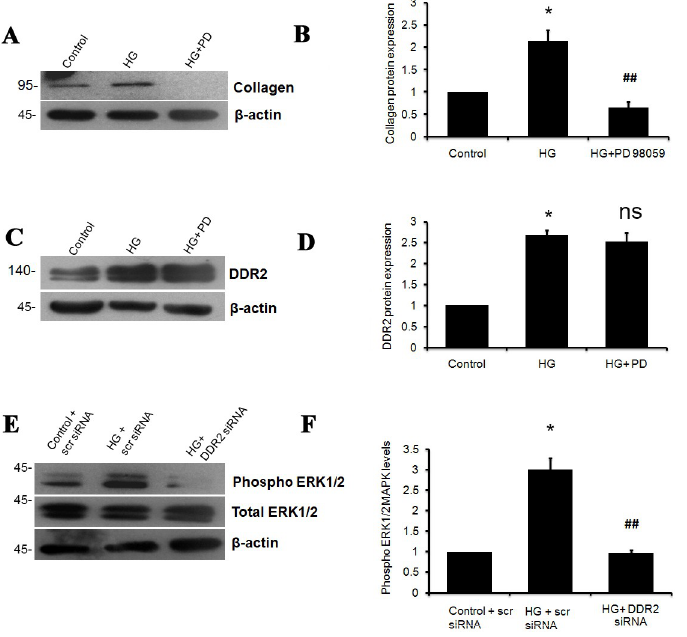
Fig 4. ERK1/2 MAPK mediates DDR2-dependent collagen gene expression in HG-treated cells. (A-D) Sub- confluent quiescent cultures of vascular adventitial fibroblasts in M199 were pre-treated with ERK1/2 inhibitor, PD98050, for 1 h and subsequently with HG for 12 h. Protein was isolated at 12 h post-HG treatment and subjected to western blot analysis for detection of: ( A and B) Collagen type I alpha 1 protein expression; � p < 0.05 vs. control, ##p < 0.01 vs. HG (One-way ANOVA p < 0.05), and ( C and D) DDR2 protein expression; � p < 0.05 vs. control, ns- not significant vs. HG (One-way ANOVA p < 0.05). β -actin was used as the loading control. ( E and F) DDR2 knockdown abolished the HG-induced activation of ERK1/2, determined by western blot analysis using anti-ERK1/2 antibody. Phospho ERK1/2 levels were normalized to total ERK1/2 levels. � p < 0.05 vs. control, ##p < 0.01 vs. HG (One-way ANOVA p < 0.05). Data are representative of three independent experiments, n = 3. Error bars represent SD.